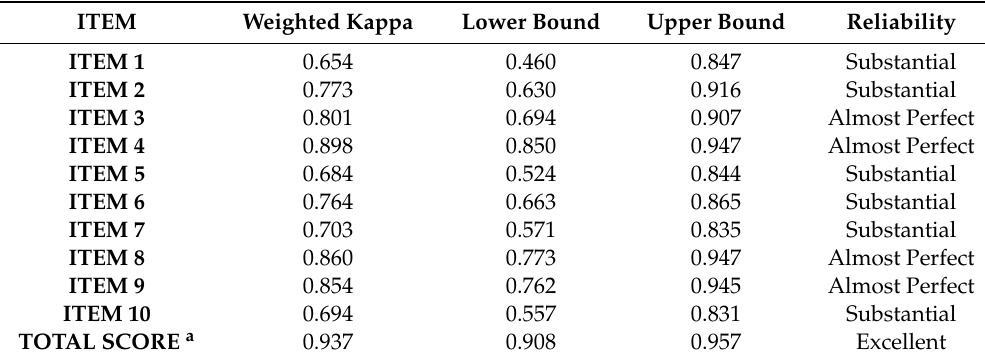
Table 5. Reliability of the items and Fonseca anamnestic index total score.